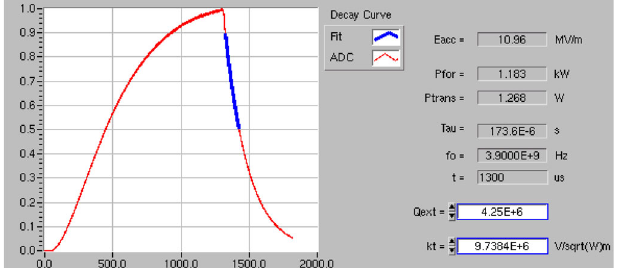
FIG. 6. Cavity frequency offset (left) and frequency offset per motor turn (right) during the tuning process. FIG. 7. Cavity transmitted power (shown in arbitrary units) using a rectangular low power rf pulse with 1.3 ms length. The bold (blue) region shows the portion of the pulse used for decay time and Q L evaluation.